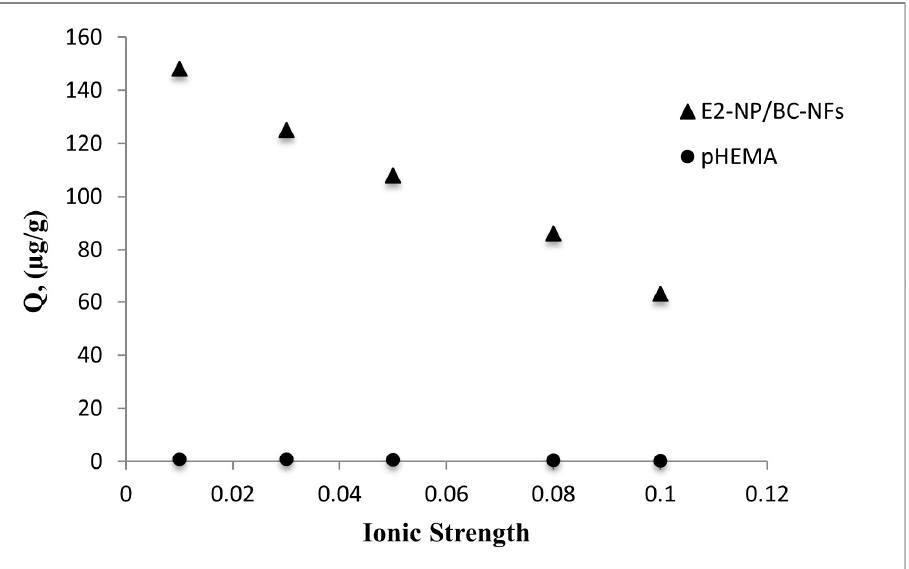
Figure 6. The effect of ionic strength on adsorption capacity: ( c 0 : 0.5 mg/mL, pH: 7.0, IS (0.01–0.1), W particles : 100 mg, t: 25 ◦